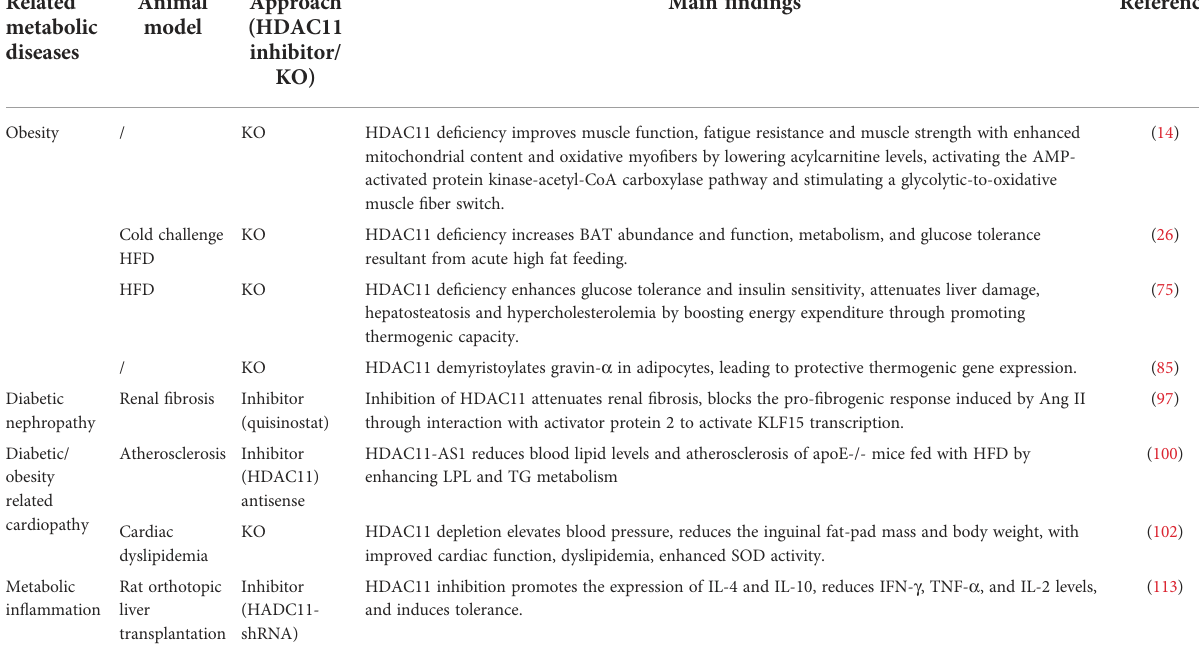
TABLE 1 The role of HDAC11 in metabolic disorders. Related metabolic diseases